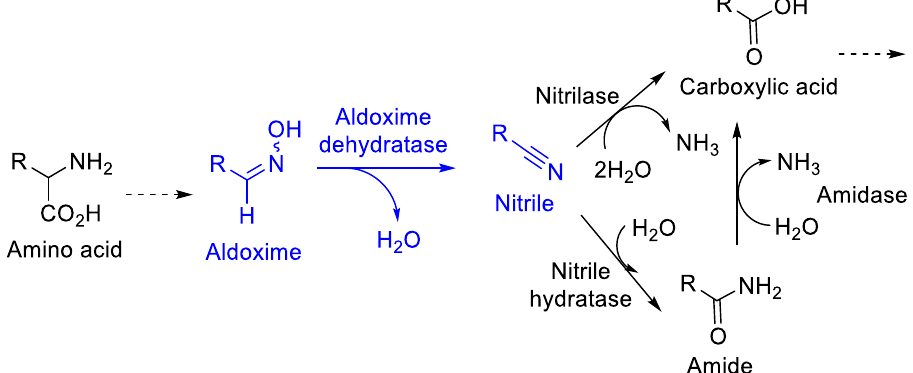
Figure 1. Scheme of the “aldoxime–nitrile-pathway” in microbes containing an Oxd-catalysed aldoxime dehydration step under formation of nitriles, which are further metabolised to carboxylic acids 2